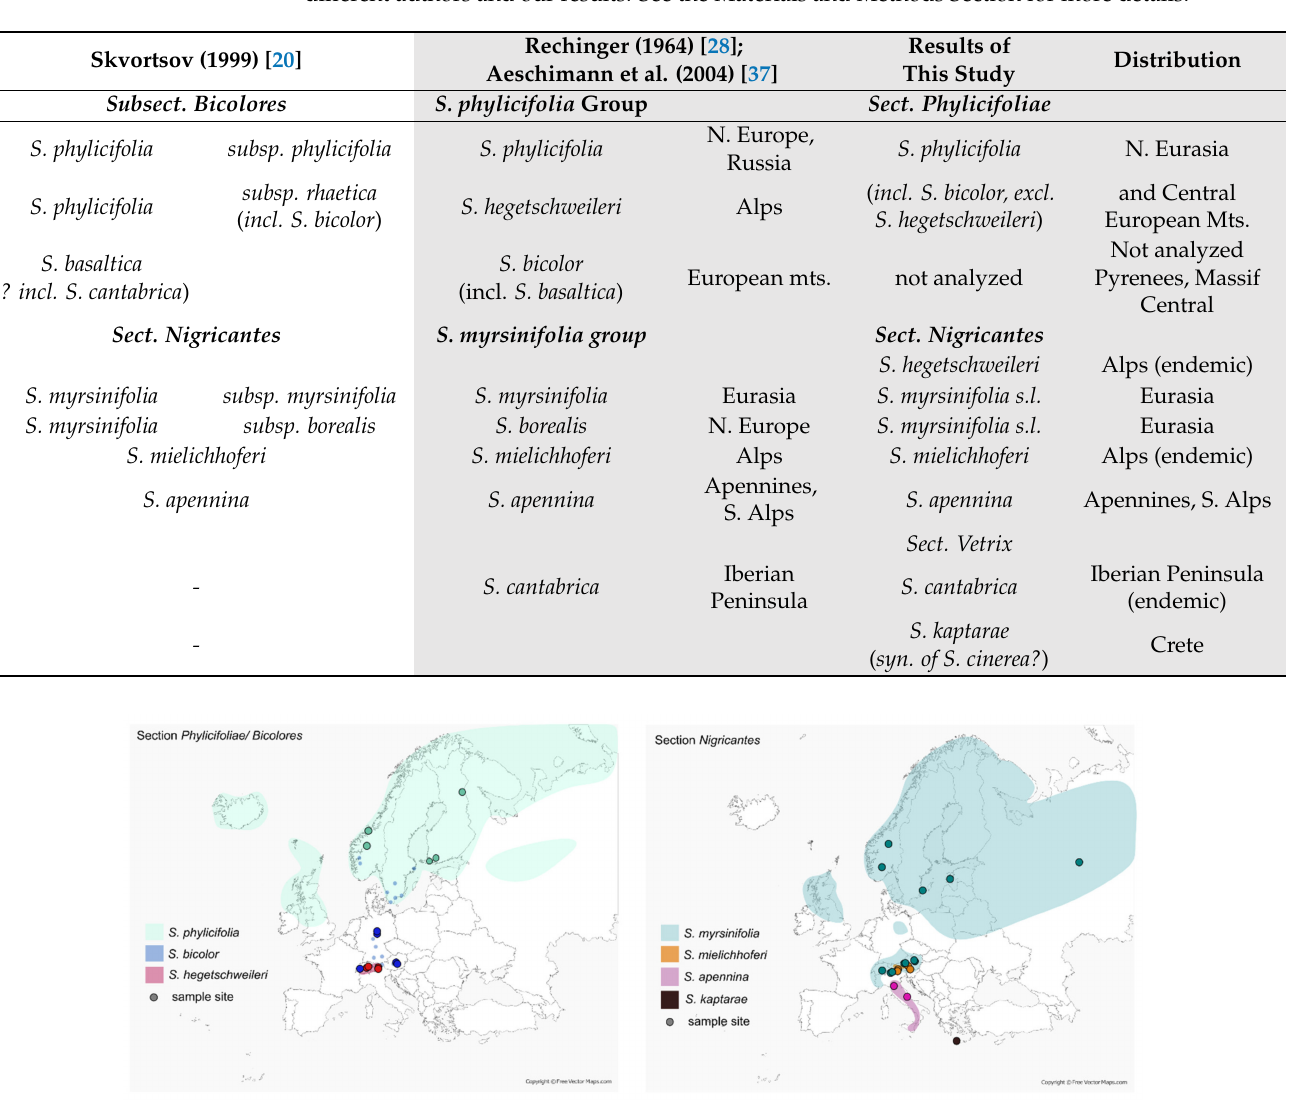
Figure 1. Distribution maps of the included hexaploid species of the sections Nigricantes and Phylici- foliae . Sample sites of the included accessions indicated as circles. Color coding according to legend within each